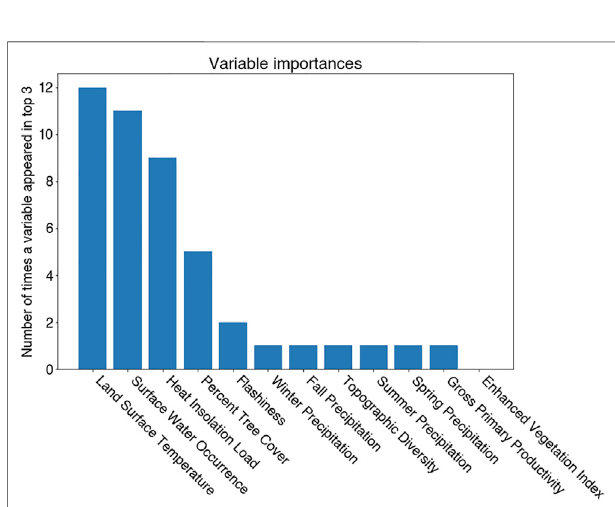
Frontiers in Big Data |